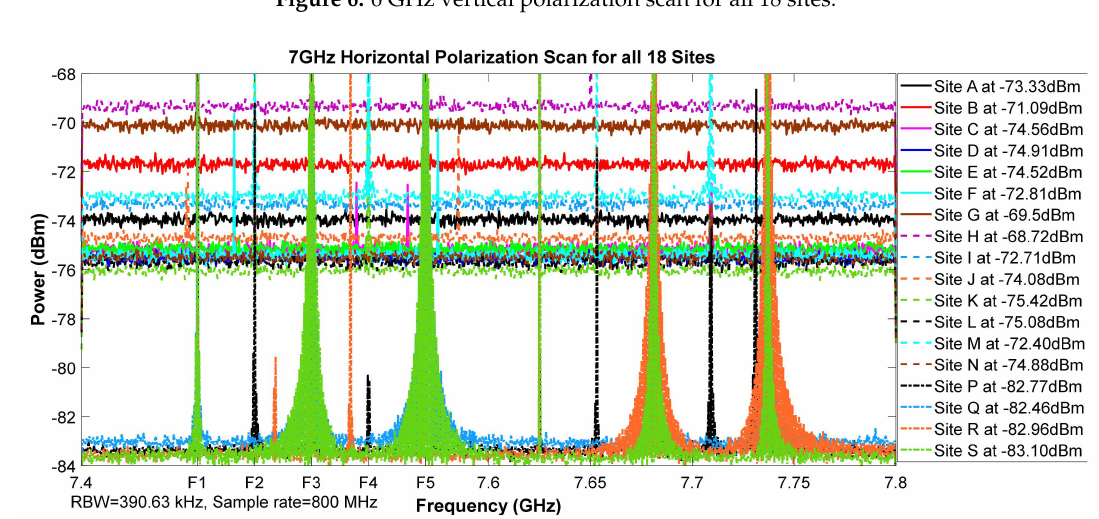
Figure 7. 7 GHz horizontal polarization scan for all 18 sites.